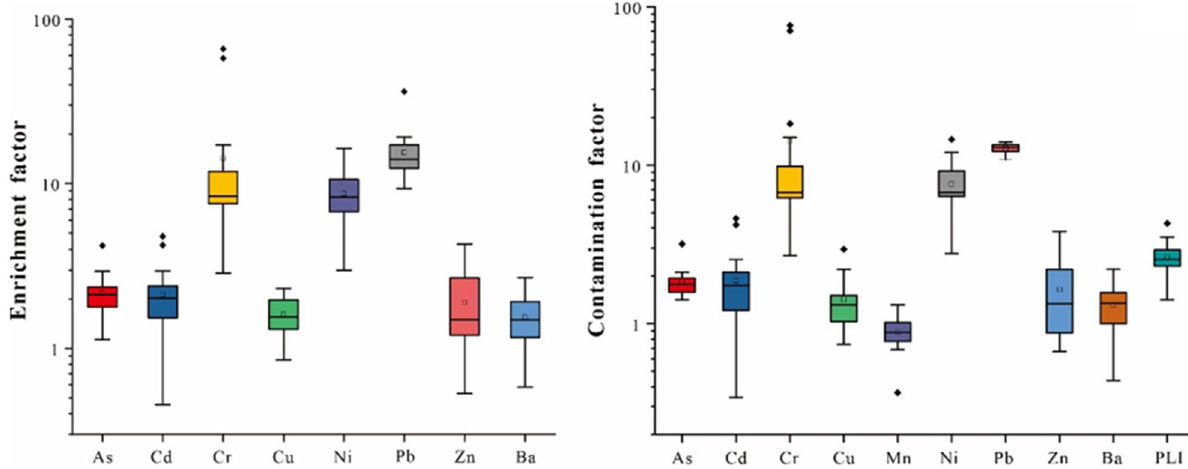
Figure 2. The map of enrichment factor and contamination factor of PTEs in the study Spatial distribution of soil PTEs in the study area. Geostatistical analysis was utilized to do ordinary Kriging interpolation of the PTEs in the study area, the results were shown in Fig. 3. As shown in Fig. 3, the spatial distribution of As, Cr, Ni, Zn and Ba was relatively consistent, and their hot spots were concentrated in the southeast, northwest, and central and eastern parts of the study area where oil wells were distributed. The spatial distribution of Cr and Ni exhibited that there were large-scale hotspots near the oil wells, and the content of Cr and Ni in these hotspots was much higher than second-level environmental quality standards of China, which proved that the content of soil Cr and Ni was significantly affected by the oil production activities of the oil production plant. There were crude oil leaks in B and C, and the contents of Zn and Ba in the vicinity of these two oil wells were relatively high, indicating that soil Zn and Ba in this area may be affected by the crude oil leakage, resulting in a certain degree of accumulation in the soil. The area with the second highest As content mainly resided in the middle of the study area. According to the survey, the herbicides were sprayed every year around the H oil well in the middle of the study area, indicating that the accumulation of As in the soil was not only related to oil extraction activities, but also to the use of pesticides (contains copper arsenate, sodium arsenate, etc.) 10, 14 . In addition, the hot spots of spatial distribution of Pb, Cd and Mn were concentrated in the